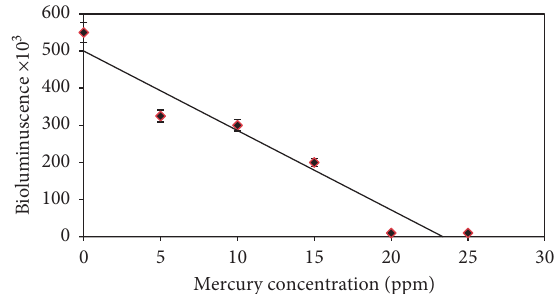
Figure 10: Effect of mercury concentration on bioluminescence level of biosensor system for 30 in after injection (aeration rate: 20ml/min, T � 37 ° C).